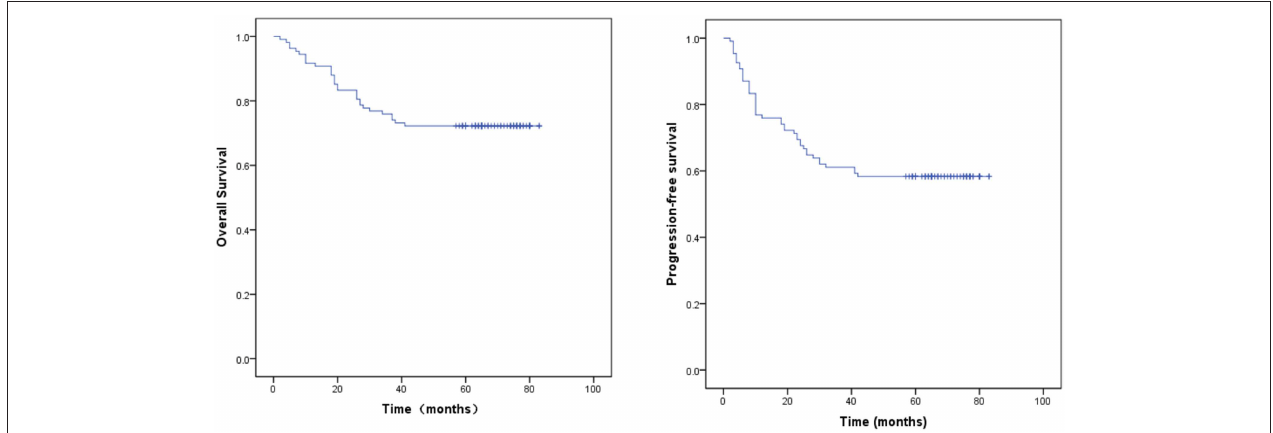
FIGURE 1 | Kaplan–Meier curves of progression-free survival (PFS) and overall survival (OS).